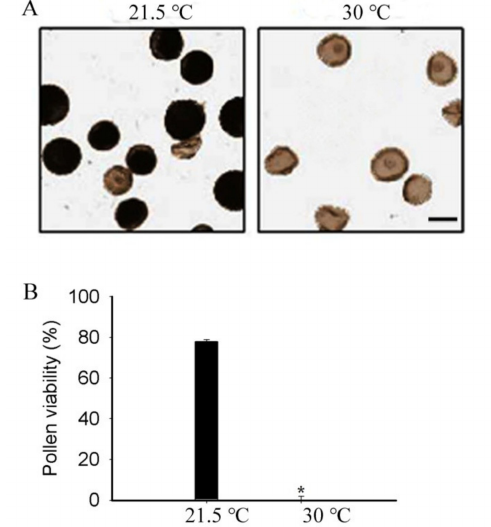
Figure 1. Pollen viability analysis of Zhu 1S under different temperatures. ( A ) Iodine–potassium staining of pollen grains from Zhu 1S under different temperatures. Bar = 100 µ m. ( B ) Pollen viability of Zhu 1S under different temperatures. The experiment was repeated three times with similar results. Asterisks represent significant differences. Error bars represent ± SD. Significant difference was found between high (30 ◦ C) and low (21.5 ◦ C) temperature ( p < 0.01 by Student’s t